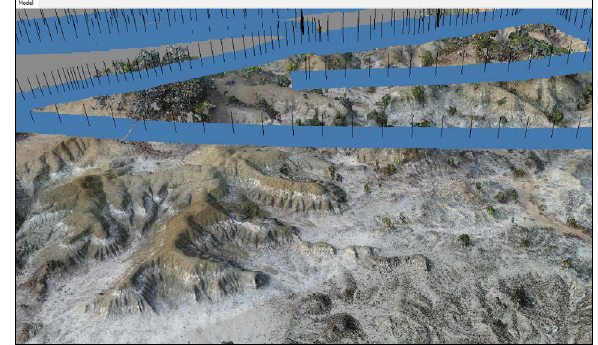
Figure 4: Screen capture from Agisoft Photoscan showing dense point cloud. The blue path represents overlapping photos (overlapping blue rectangles), with the thin, black lines marking the centre point of each